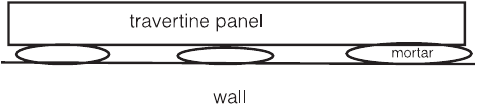
Fig. 1. Hypothetical stratigraphical section with the panel of travertine 3 cm thick, the mortar with layer ranging from about 1 cm to some cm, and the